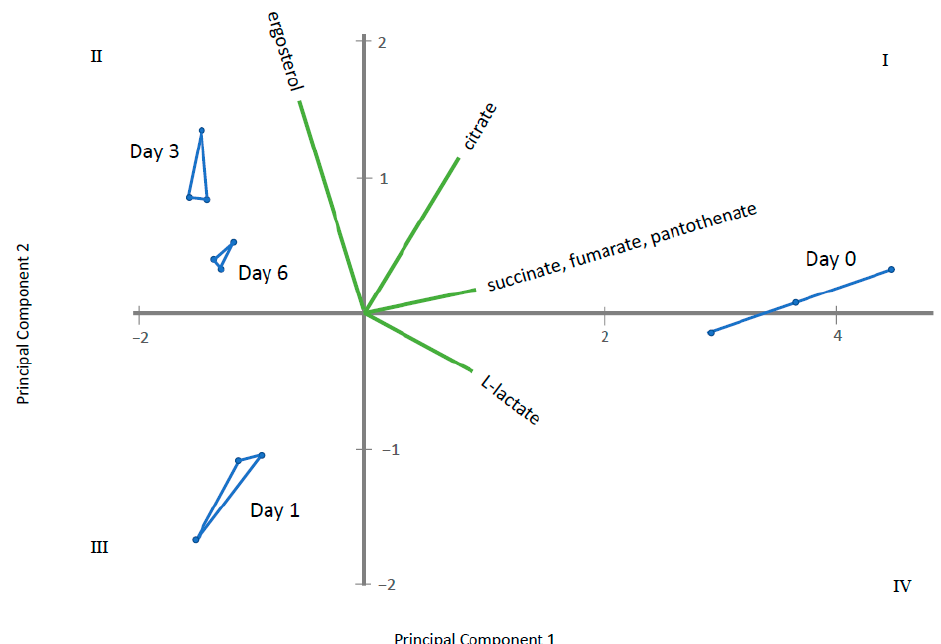
Figure 8. Principal Component Analysis (PCA) for other acids and other alcohols detected where Principal Component 1 displays 82.3% of the variability and Principal Component 2 16.4%. The green vectors represent each metabolite, whose projection of the vertex on each axis represents its contribution to each PC. The blue points are each sampling time repli- cate, connected by lines to represent the PC scores of the samples analyzed.